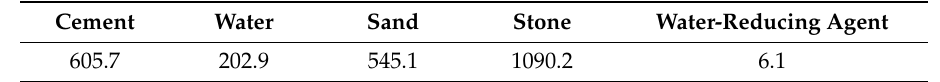
Table 2. Mix proportions of normal strength concrete (NSC) (kg / m 3 ).